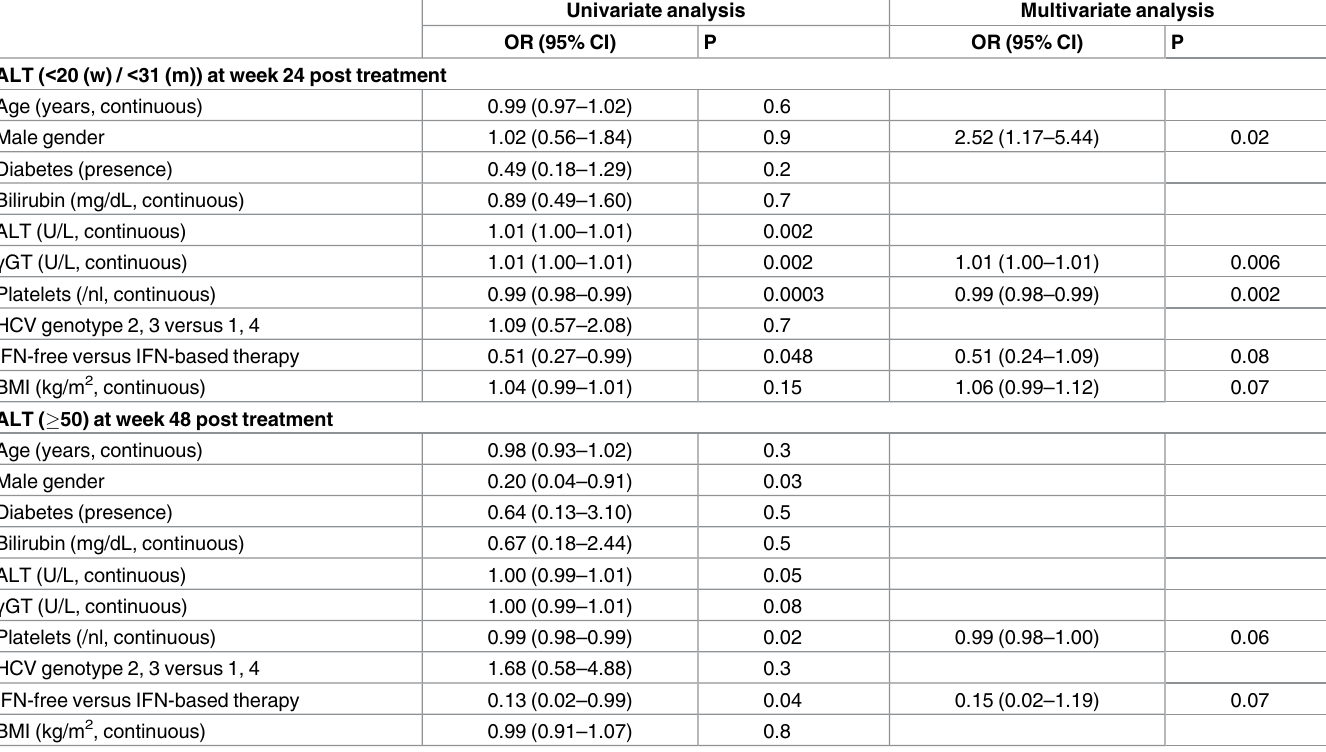
Table 4. Logistic regression analyses of alanine aminotransferase after HCV